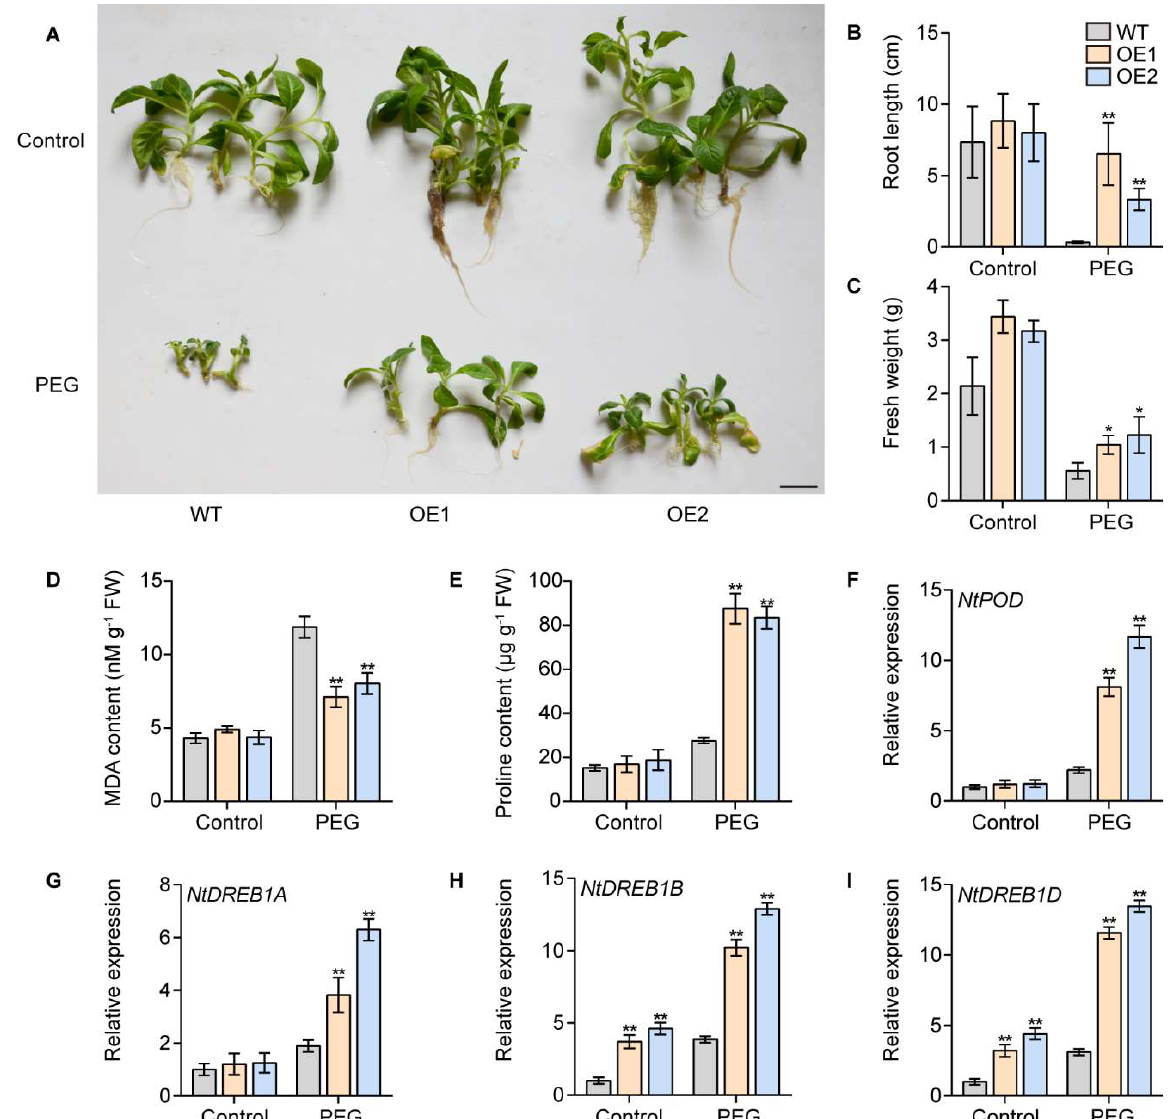
Figure 10. Drought tolerance identification of WT and IbPIF3.1 -OE transgenic tobacco plants cultured on MS medium without (control) or with 20% PEG6000 for 4 weeks: ( A ) phenotypes; ( B ) root length; ( C ) fresh weight (scale bar = 2.5 cm); ( D ) MDA content; and ( E ) proline content in the leaves of plants after 4 weeks of treatment. Transcript levels of ( F ) NtPOD ; ( G ) NtDREB1A ; ( H ) NtDREB1B ; and ( I ) NtDREB1D in the leaves of plants after 4 weeks of treatment. The transcript levels of the genes in WT without treatment control were set to 1. The values were determined by qRT-PCR from three biological replicates consisting of pools of three leaves. The error bars indicate ± SD ( n = 3). *, p < 0.05; **, p < 0.01; Student’s t –test.